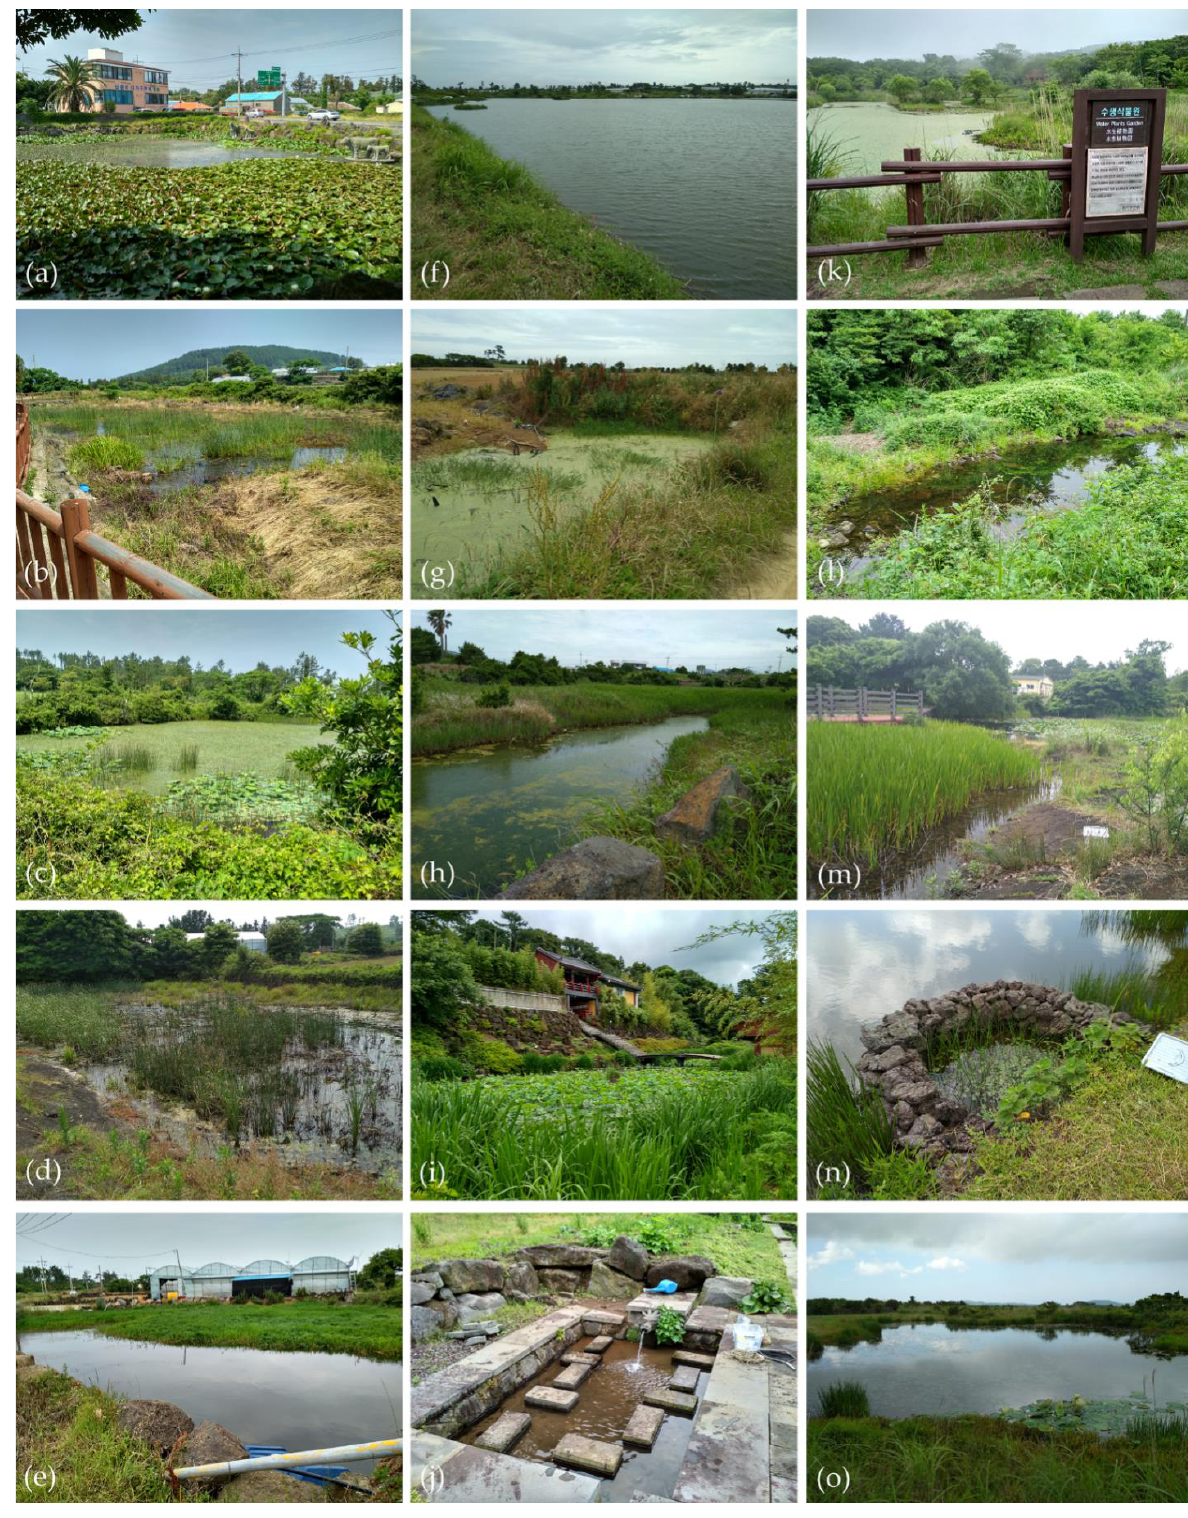
Figure 2. Some localities sampled in June 2018: ( a ) locality 6; ( b ) locality 7; ( c ) locality 8; ( d ) locality 14; ( e ) locality 19; ( f ) locality 19; ( g ) locality 23; ( h ) locality 27; ( i ) locality 39; ( j ) locality 41; ( k ) locality 44; ( l ) locality 47; ( m ) locality 52; ( n ) locality 62; ( o ) locality 63. All samples were collected by small plankton nets or dip nets (with 50 µm mesh) and fixed with 4% formaldehyde or 96% ethanol. They were studied in the laboratory using a